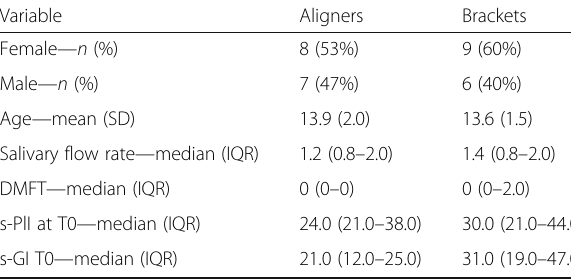
Table 1 Descriptive data of the included